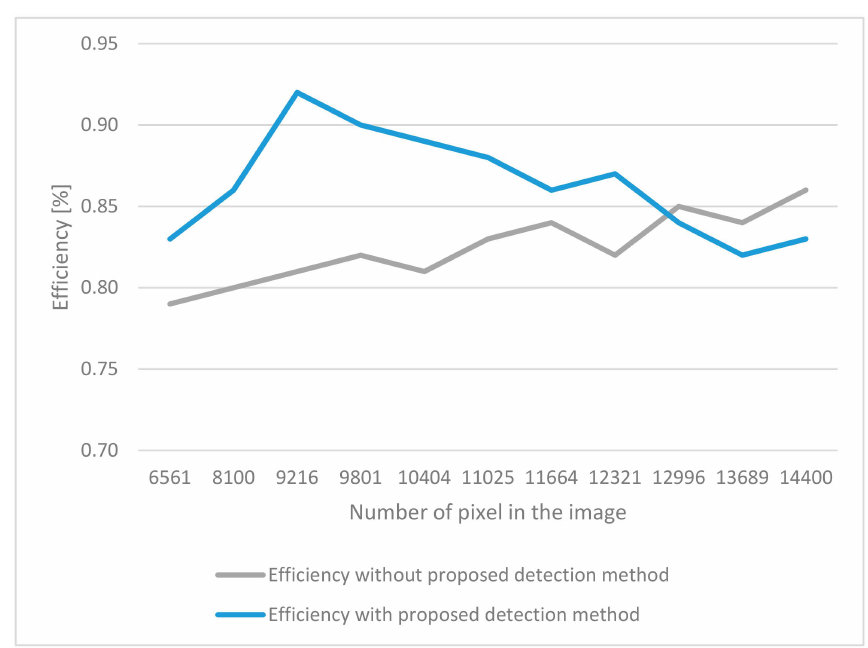
Figure 4. Measurement of the e ff ectiveness of the techniques relative to the size of the incoming image.